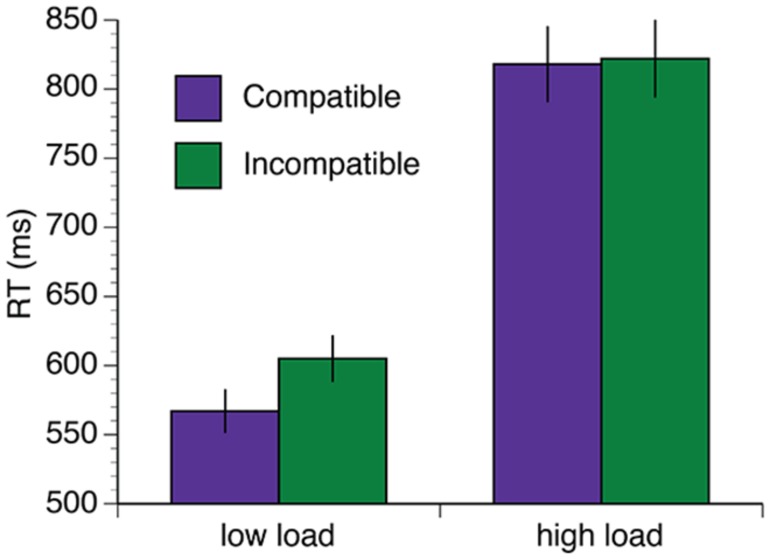
Distractor incompatibility effect under low load but not high load. Error bars represent SEM.